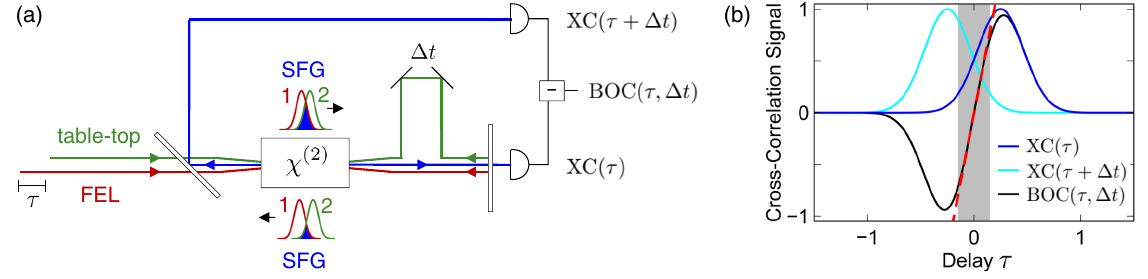
FIG. 1. Principle of two-color balanced optical cross-correlation. (a) Experimental scheme. Sum-frequency generation of FEL and table-top laser radiation is done twice within a single nonlinear crystal ( χ ð 2 Þ ≠ 0 ) after inserting a small, fixed time delay Δ t between FEL (1) and table-top laser (2) pulses. Measured forward, XC ð τ Þ , and backward, XC ð τ þ Δ t Þ , cross-correlation signals as a function of the delay τ between FEL and table-top pulse are used to determine the balanced value, BOC ð τ ; Δ t Þ . (b) Illustration of normalized cross- correlation and BOC functions. The BOC curve is calculated according to Eq.